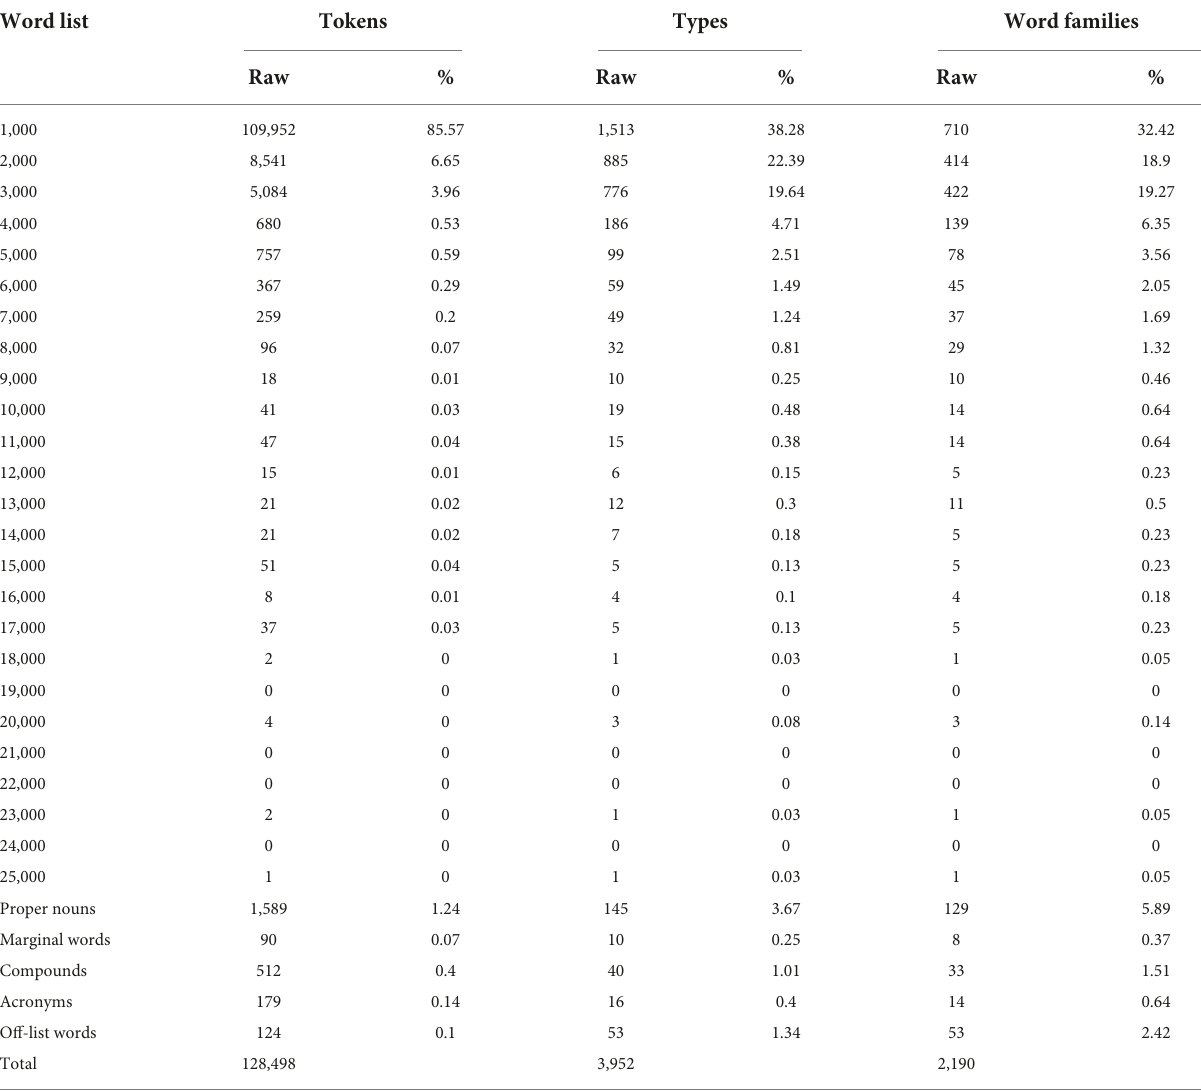
TABLE 2 Tokens, types, and word families at each word level for the entire present corpus. Word